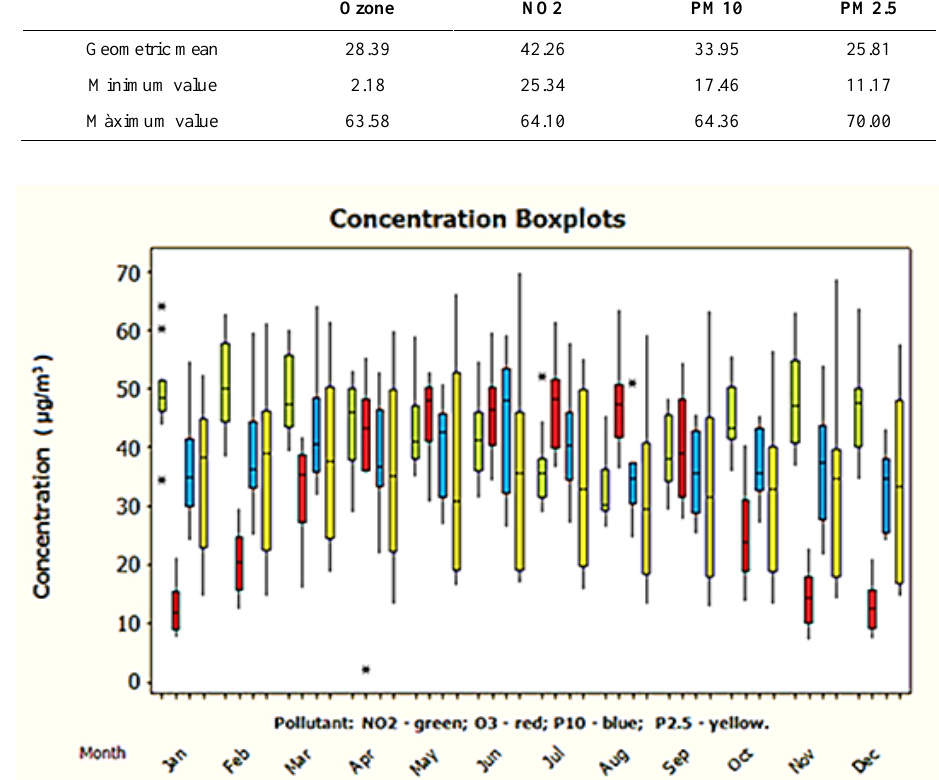
Figure 4. Pollutants’ concentration boxplot in